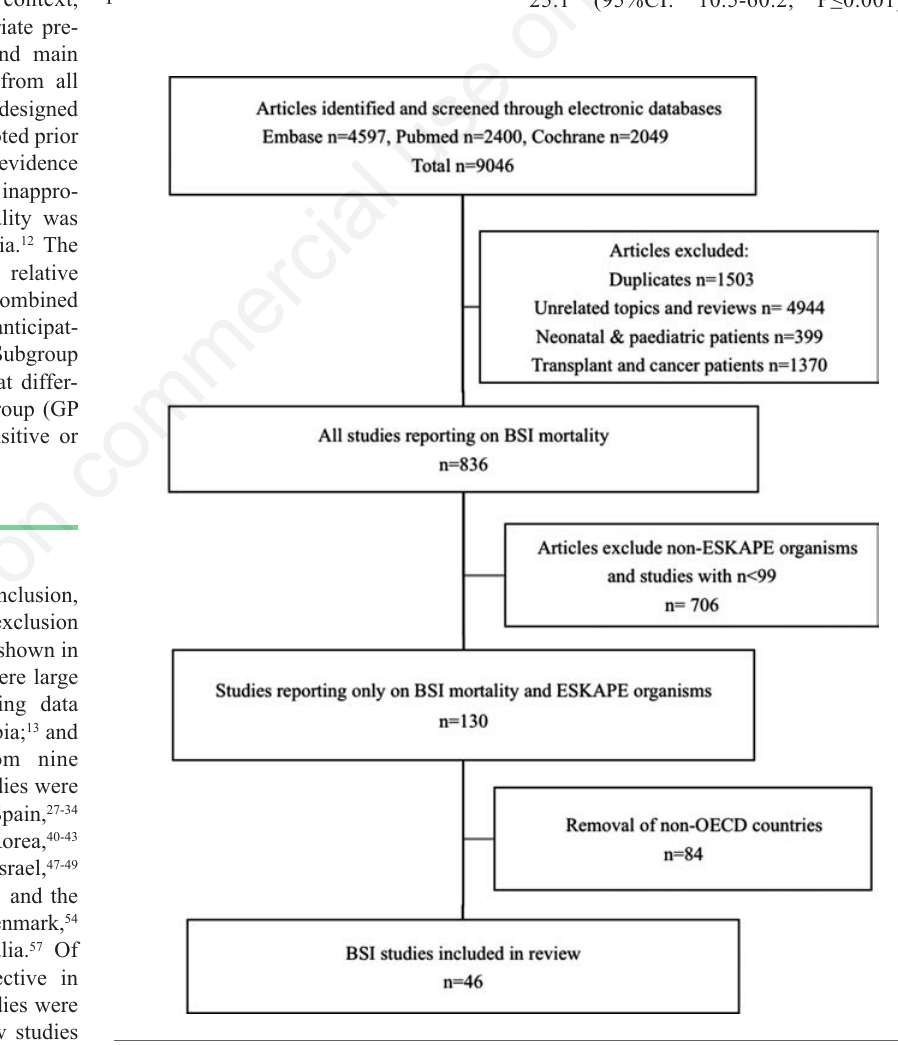
Supplementary Figure S1. All retrieved